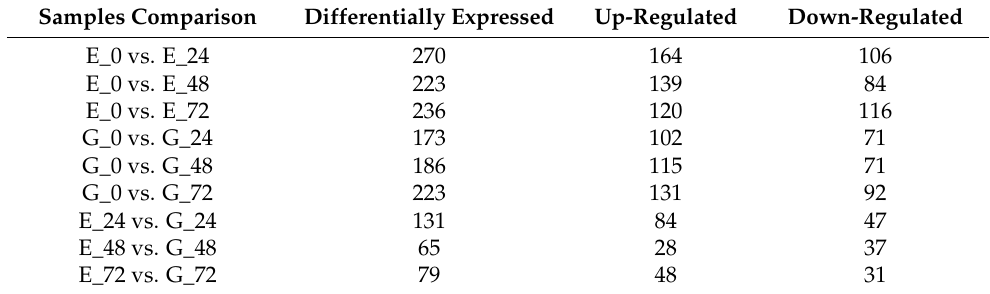
Table 3. The number of differentially expressed miRNAs in sweet potato after sweet potato weevil infection. Samples